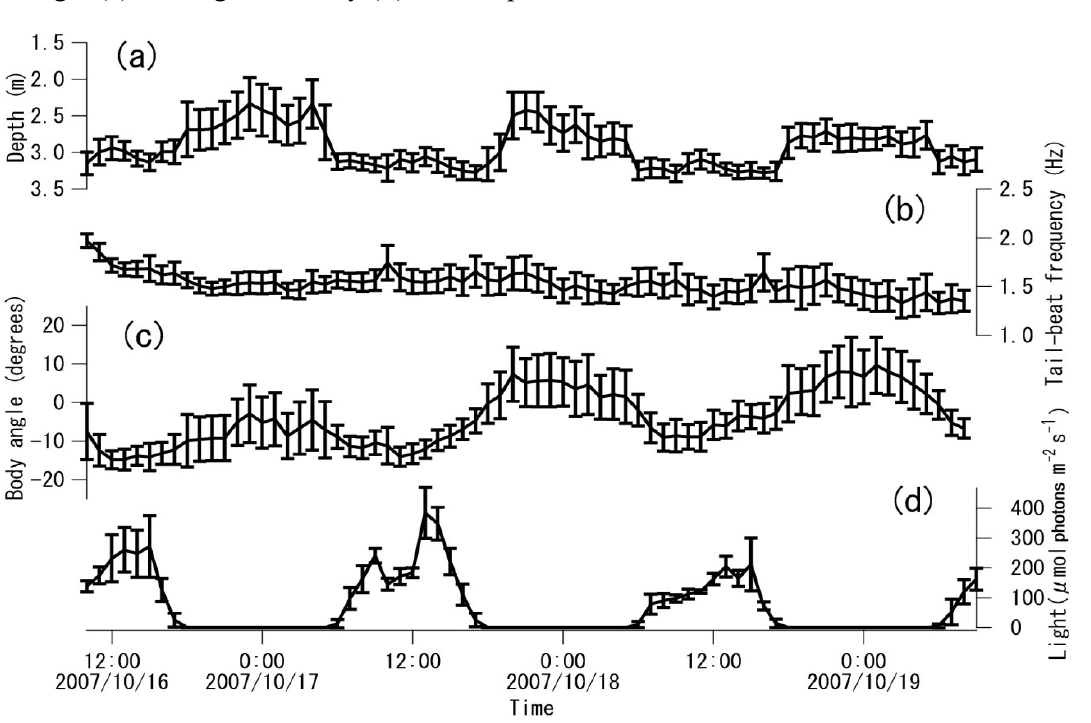
Figure 1. Example (for one individual) of 1-h means of depth ( a ), frequency of tail beat ( b ), tilt angle ( c ), and light intensity ( d ). Bars represent standard